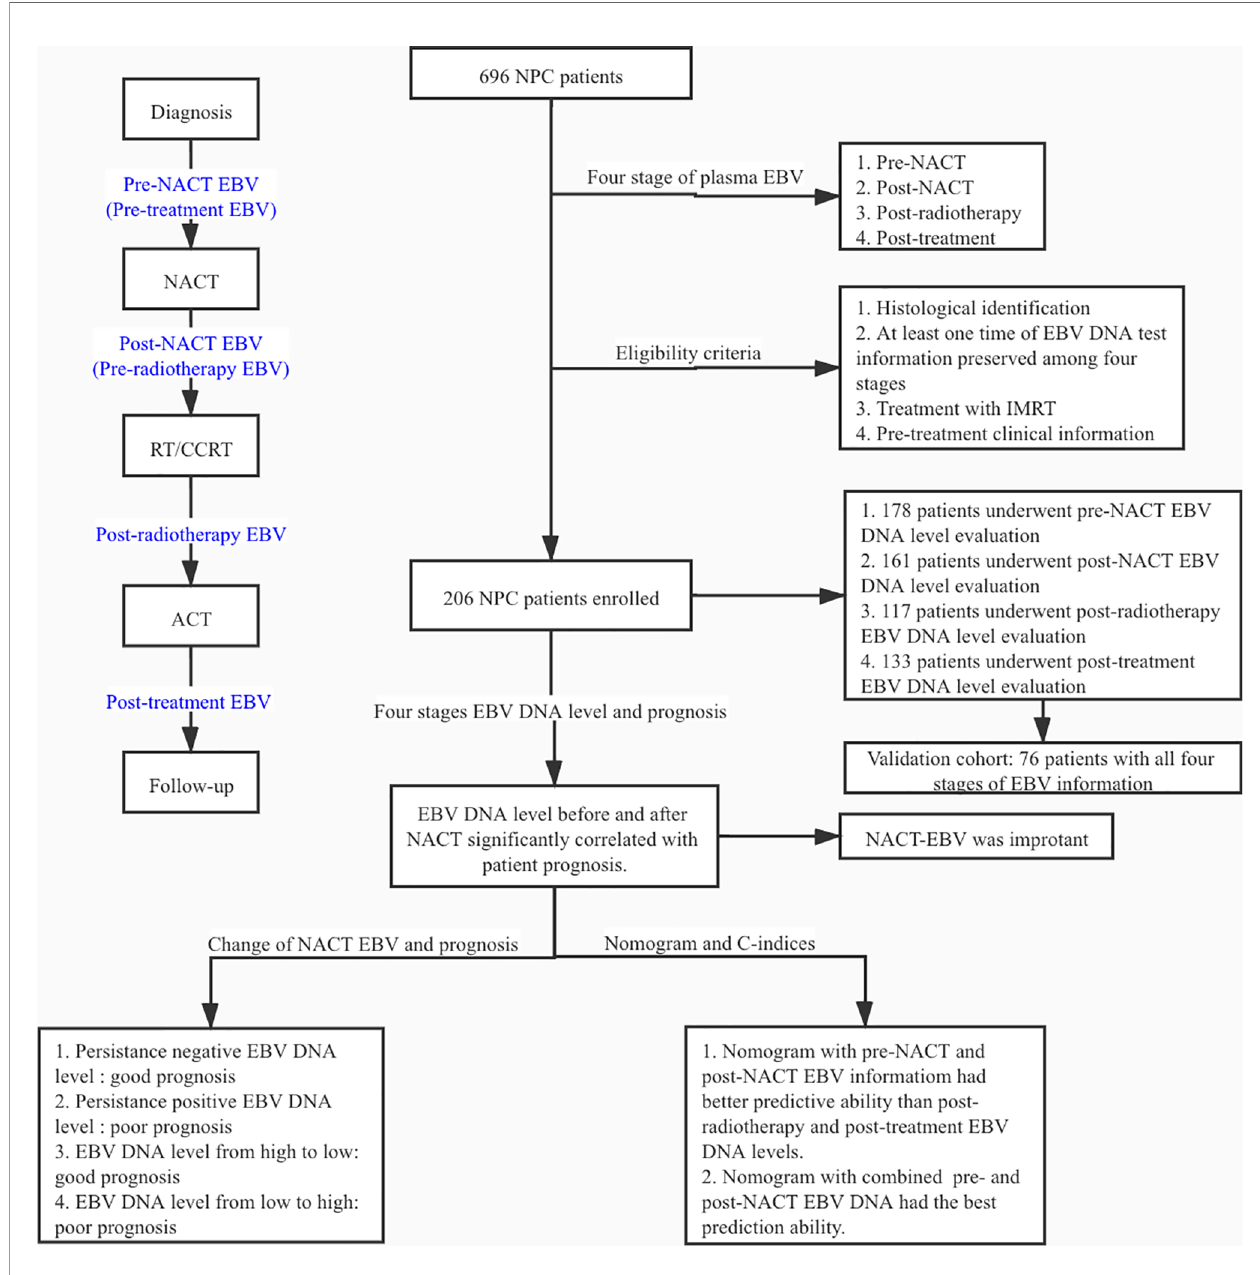
FIGURE 1 | Flow chart of this